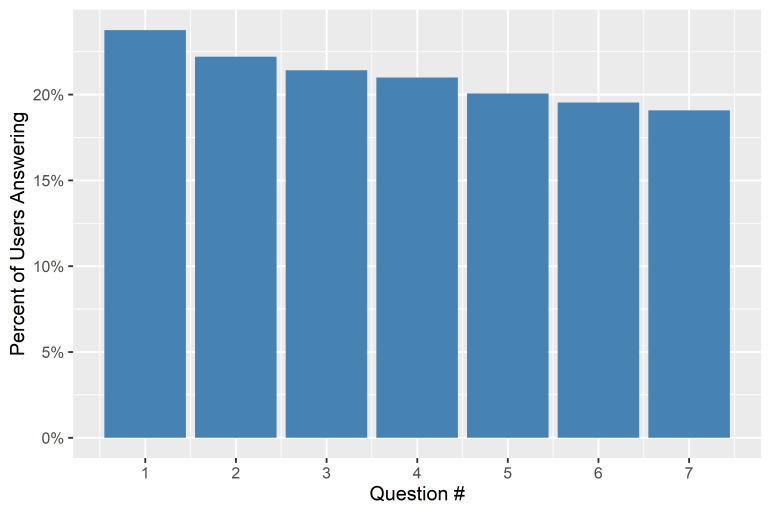
Survey completion.